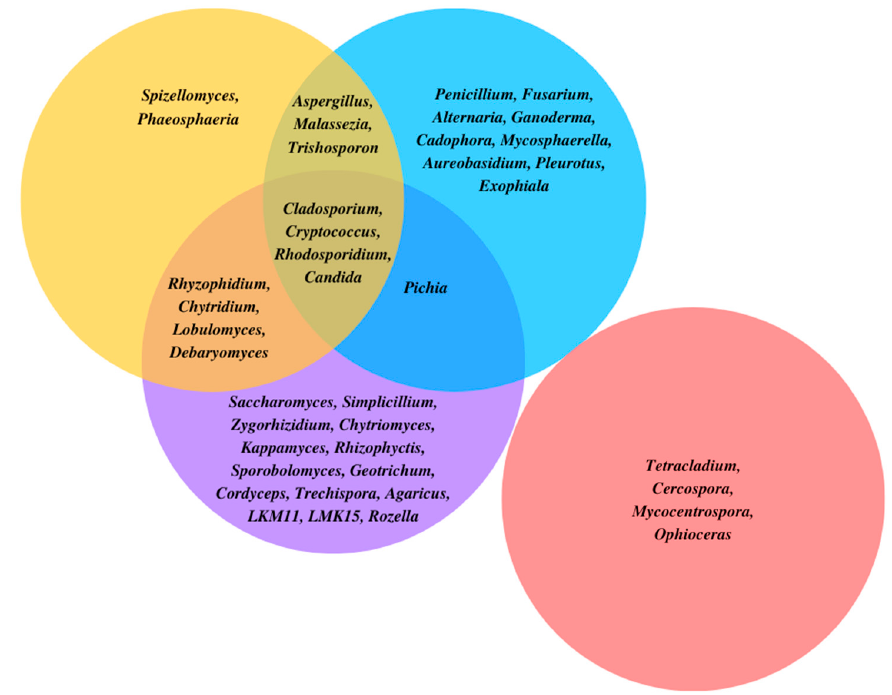
Figure 1. Predominant genera in different aquatic habitats. Yellow: coastal and oceanic environments; Blue: deep sea and sub-sea floor; Purple: lakes; Red: rivers, streams, and ponds.